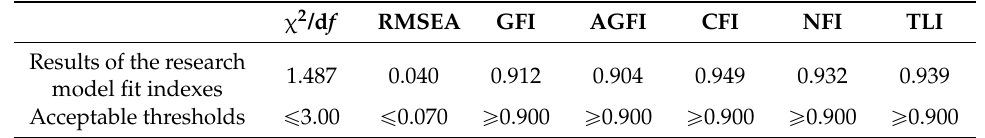
Table 9. Model fit index summary.